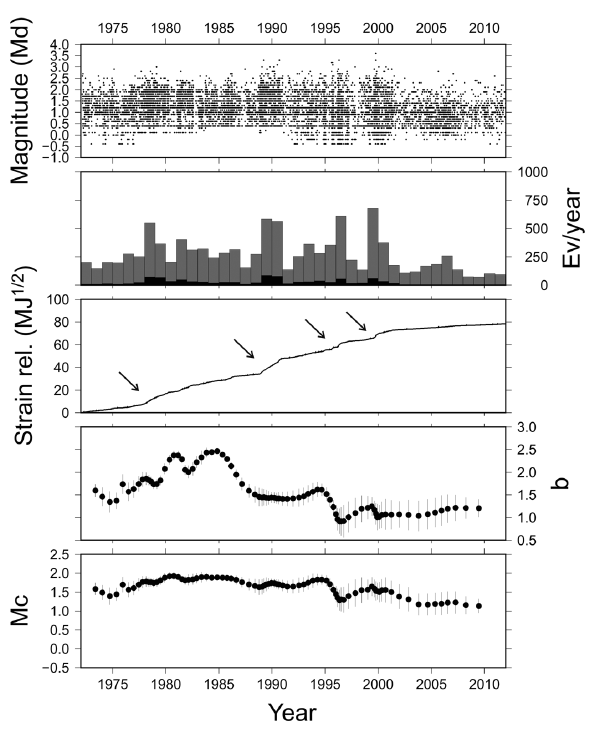
Figure 3. Time series for the OVO catalogue. The first panel shows the event magnitudes while the second one the number of events for each year. The superimposed black histogram represents the number of events having M ≥ 2.0, which is the maximum value of M in the bottom panel. The third represents the cumulative Benioff c strain release. Arrows indicate episodes of increased release rate. The fourth panel shows the temporal variation of the b-value. Ver- tical error bars indicate the 1 v uncertainty. The last panel shows values with their 1 v error bars. the M c